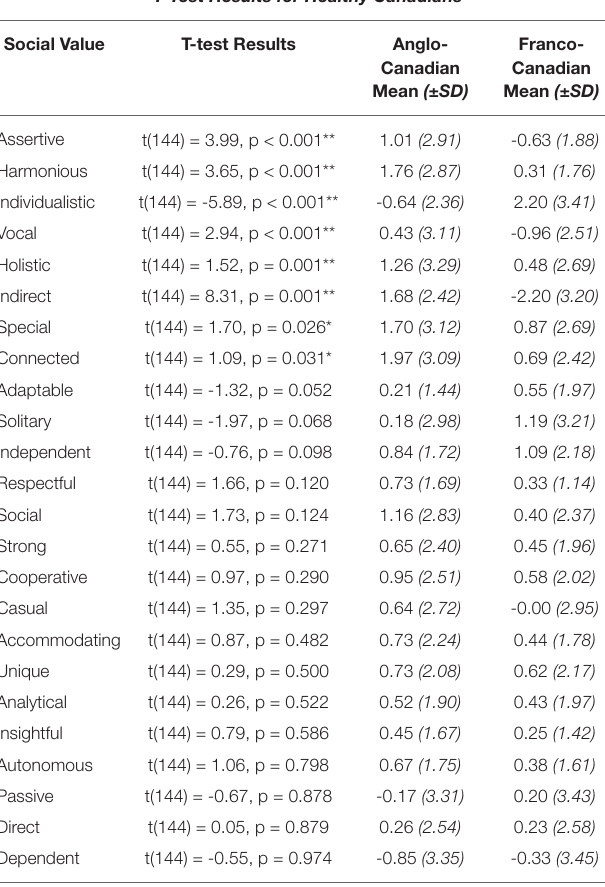
TABLE 2 | T-test comparisons further describe patterns of social values across Canadian cultural groups. Independent samples t-tests quantify observed groupwise differences. This table on the right depicts the varying degrees to which Franco- and Anglo-Canadian subscribe to each social value relative to each other, adjusted for their shared cultural